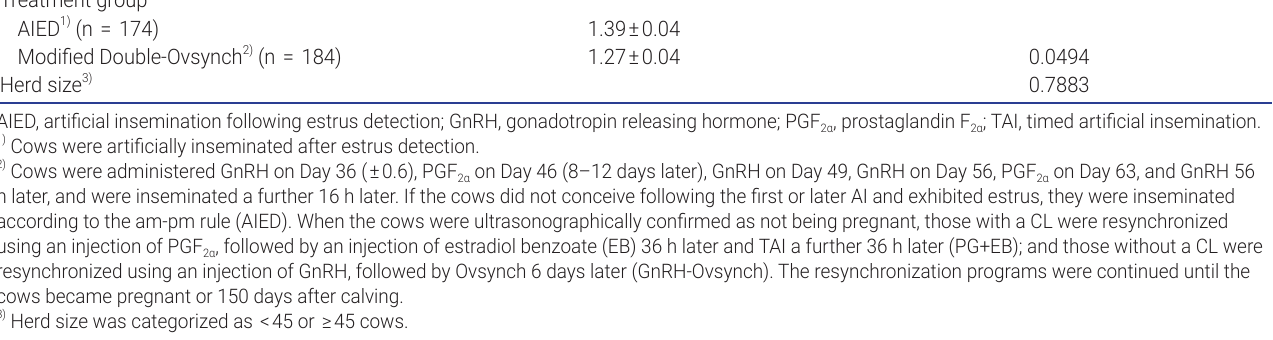
Table 4. Least squares mean number of inseminations per conception